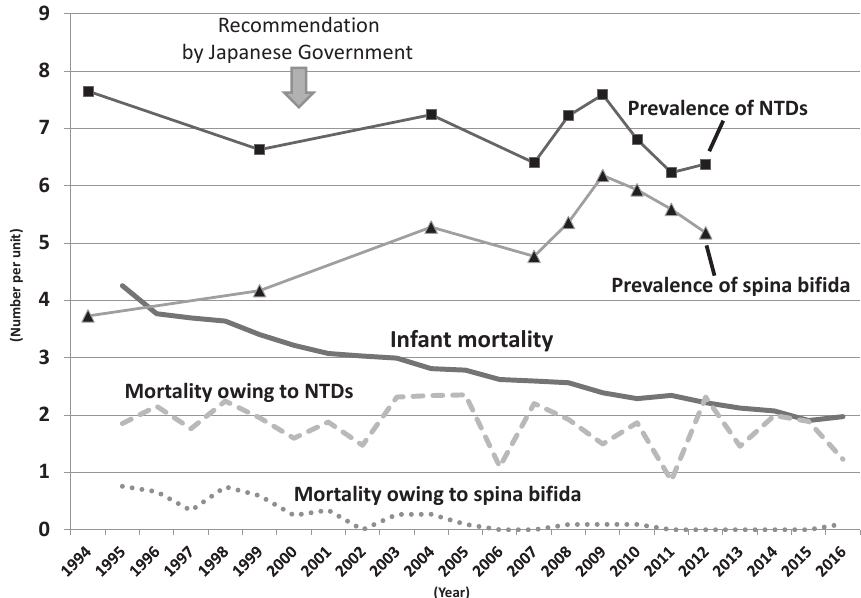
Figure 1. Trends in prevalence and mortality under 1 year of age of neutral tube defects (NTDs), as well as infant mortality in Japan from 1994 to 2016. The units are one per 1,000 births for infant mortality, one per 100,000 births for mortality owing to NTDs and spina bi fi da, and one per 10,000 births for prevalence. The International Classi fi cation of Diseases- 10 codes are Q00, Q01, and Q05 for NTDs and Q05 for spina bi fi da. Mortality information was obtained from Vital Statistics from Ministry of Health, Labour, and Welfare in Japan. Prevalence for NTDs ( ) and spina bi fi da ( ) information was obtained from the Annual Report 2009 – 2014 published by the International Clearinghouse for Birth Defects Surveillance and Research and prevalence before 2006 was average of the prevalence during the 5 years (eg, 5-year average of the prevalence from 2002 to 2006 is shown in